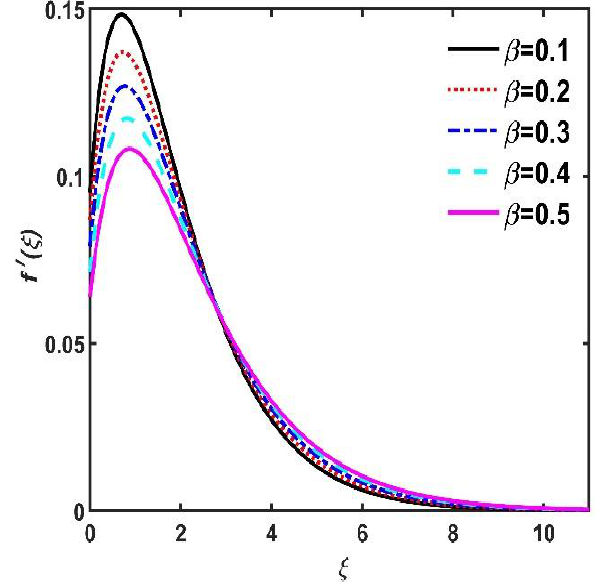
Figure 6. Impact of 𝛽 on 𝑓′(𝜉) .